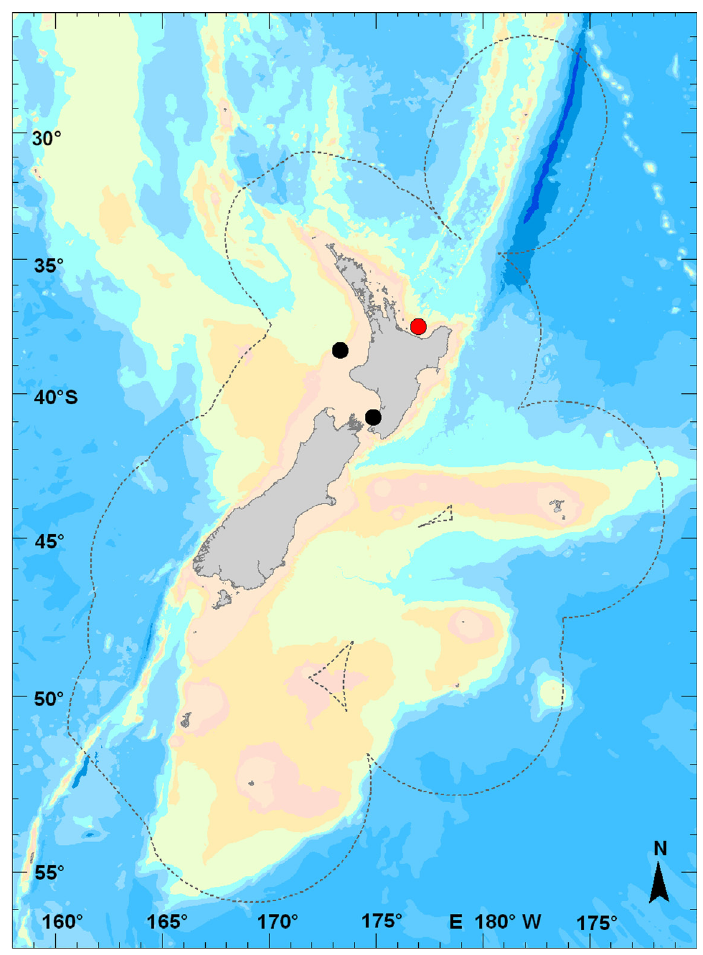
Fig. 4. Distribution of Echiodon prionodon. The red circle depicts the locality where the holotype was